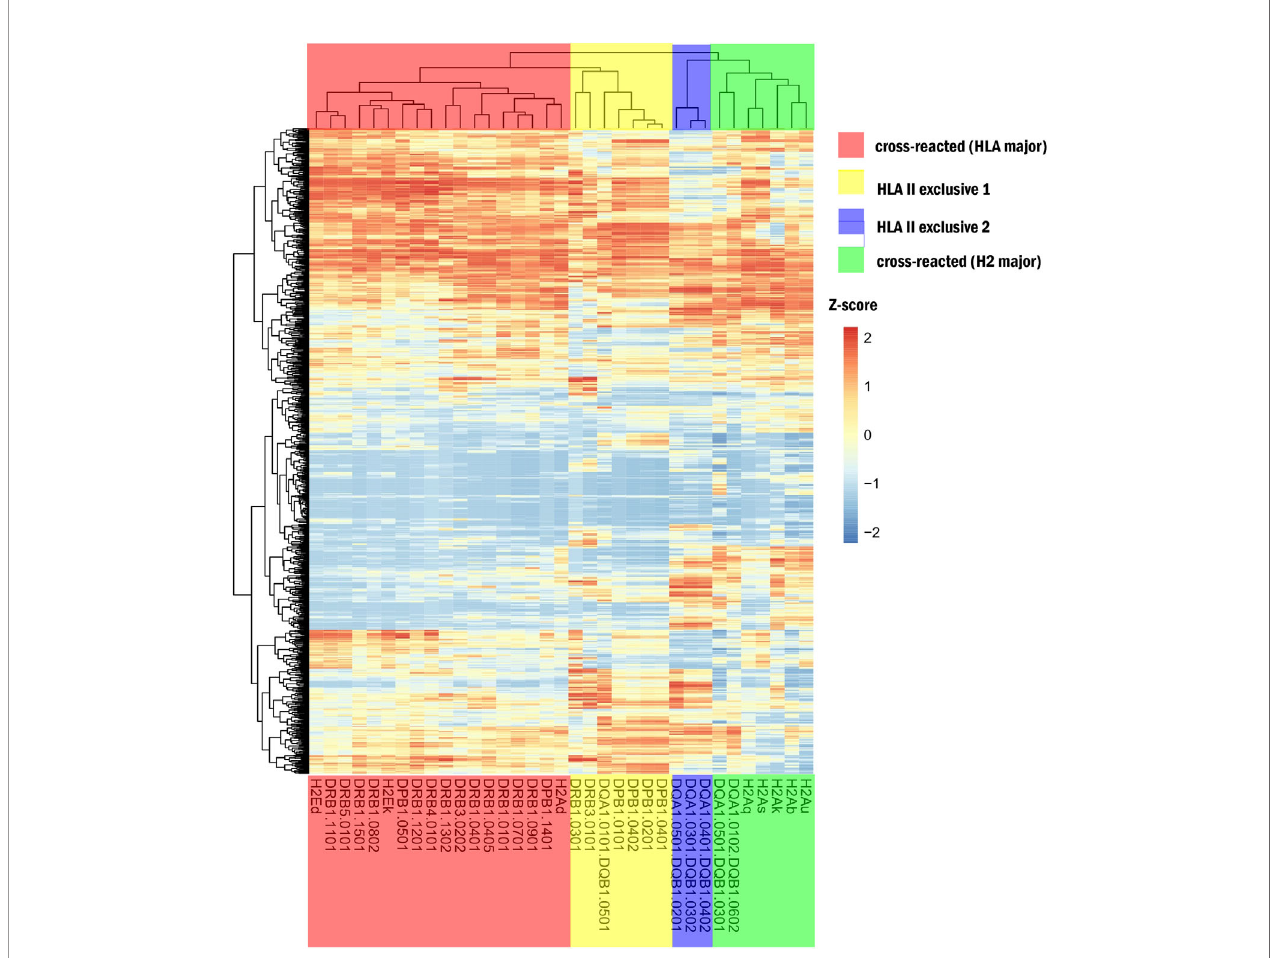
FIGURE 3 | Heatmap for different MHC-II. The red region shows cross-reactive epitope clusters (HLA major) including DRB1 and 3 H2 subtypes (H2-Ed, k, and H2- Ad) corresponding to BALB/c and C3H mice; the yellow region is HLA-II exclusive 1, which includes DPB1 and DRB; the blue region is HLA-II exclusive 2, which comprises DQA1/DQB1; and the green region is a cross-reactive cluster (H2 major) with H2-Au, b, k, s, q, and 2 HLA subtypes. The extraction capacity of adjacent MHC molecules was